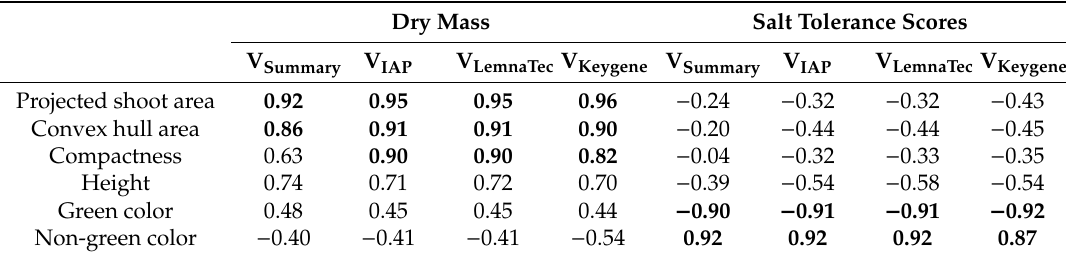
Table 3. Validation of the high-throughput phenotyping (HTP) workflow by taking the correlations between manually measured traits and automatically processed phenotypic traits calculated from the four di ff erent digital volume formulae at day 54 of the HTP experiment. Significance ( p < 0.0001) is indicated in bold.